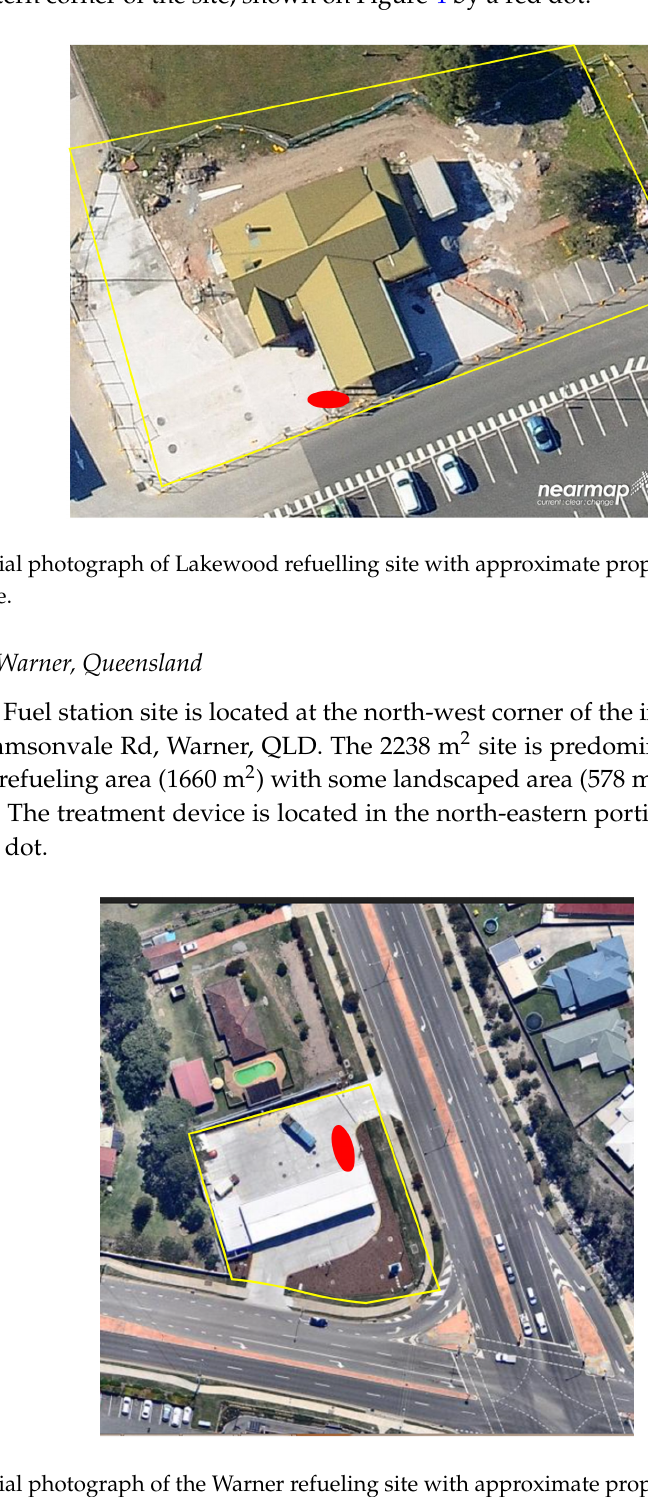
Figure 5. Aerial photograph of the Warner refueling site with approximate property boundary shown by yellow line.